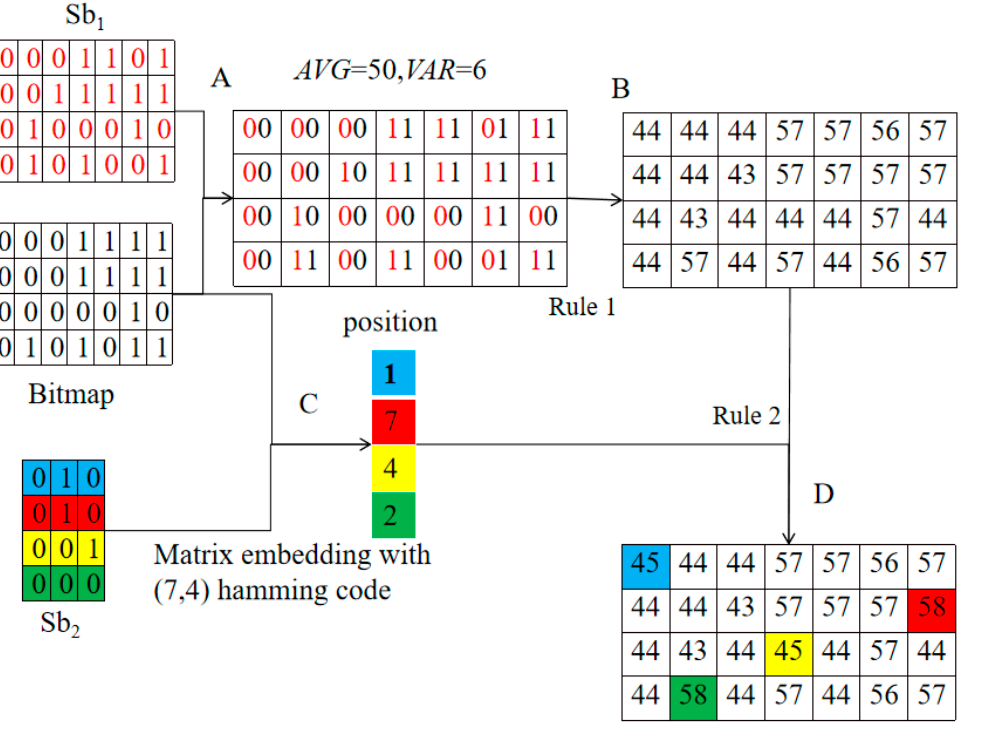
Figure 3. Example of embedding phase. Note: Rule 1 indicates Lin et al.’s data hiding strategy, it is also the hiding strategies adopted in the first layer. Rule 2 is the hiding strategies designed in the second layer.